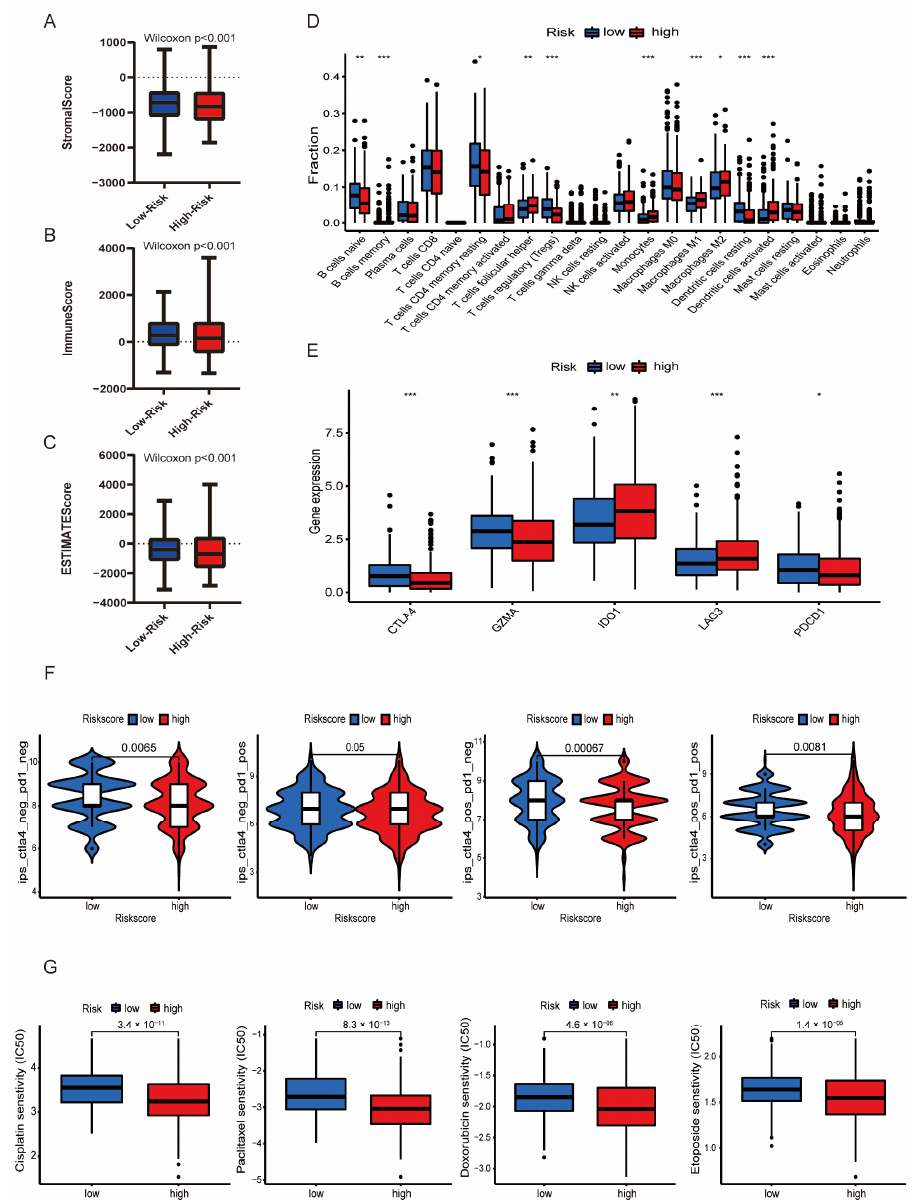
Figure 6. Immune landscape associated with the LMRG- and FAG-based signature. ( A – C ) Differences in stromal score, immune score, and ESTIMATE score between the high- and low-risk groups. (Wilcoxon, p < 0.05). ( D ) The difference in 22 immune infiltrating cells in the TCGA-UCEC samples between the high- and low-risk groups was analyzed by the Wilcoxon test. ( E ) The connection between immune checkpoint molecules (CTLA4, GZMA, IDO1, LAG3, and PDCD1) and risk scores. ( F ) Prediction of immunotherapy response to anti-PD-1 and anti-CTLA4 in patients in different risk groups. ( G ) Estimated IC50 values of four typical immunotherapy drugs (cisplatin, paclitaxel, doxorubicin, and etoposide) between the low- and high-risk groups. * p < 0.05, ** p < 0.01, and *** p < 0.001.